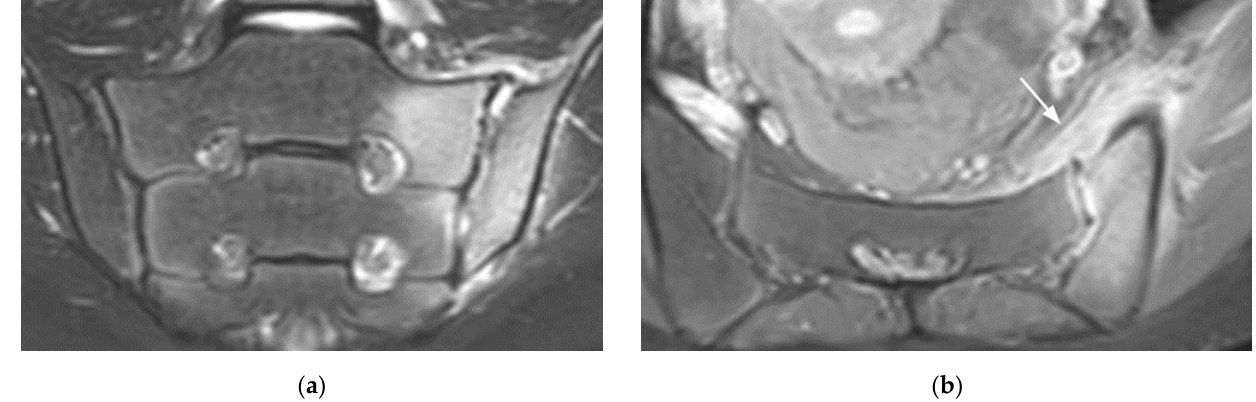
Figure 10. Left infectious sacroiliitis in a 14-year-old girl (coronal oblique T2- ( a ) and axial fat-suppressed post-gadolinium T1- ( b ) weighted images). Extensive BME, abundant joint fluid, joint space enhancement, and extra-articular inflammatory changes in the adjacent soft tissues and muscles (arrows).